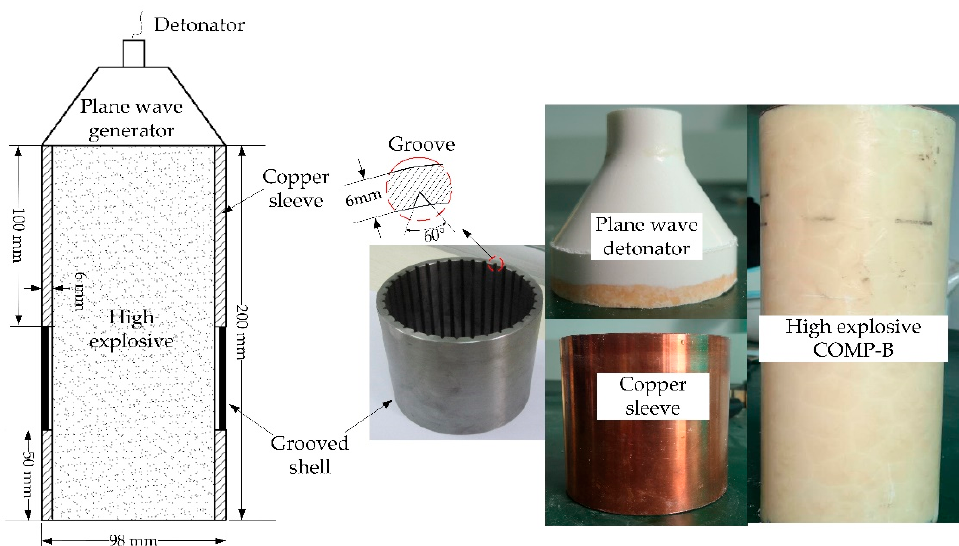
Figure 16. Schematic of experimental assembly. The grooved shell was placed between two copper sleeves and subjected to a plane-strain load that passed down the stacked cylinders.